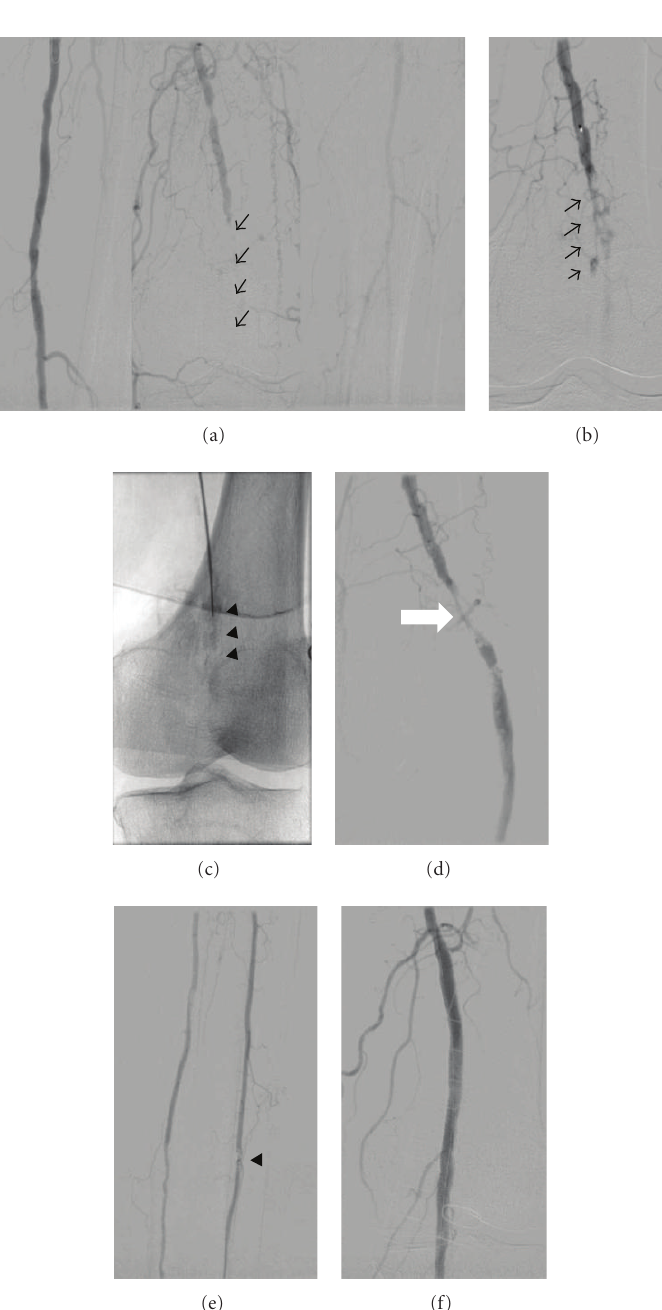
Figure 2: (a) Control angiography reveals a mild plaque in the proximal-middle region of the SFA and a short calcified occlusion in the proximal popliteal artery; distal popliteal artery is observed via few collaterals. (b) Lesion crossing results in subintimal wire tracking and development of the false lumen (black arrows). (c) The calcified occlusion was carefully probed (black arrowheads) by using the sti ff end of the Terumo glidewire for sharp recanalization. (d) The true lumen is observed after sharp recanalization (white arrow). (e) Small atherosclerotic emboli are noted in the middle portion of peroneal artery (black arrowhead). (f) Good angiographic results are obtained after subsequent angioplasty and stent